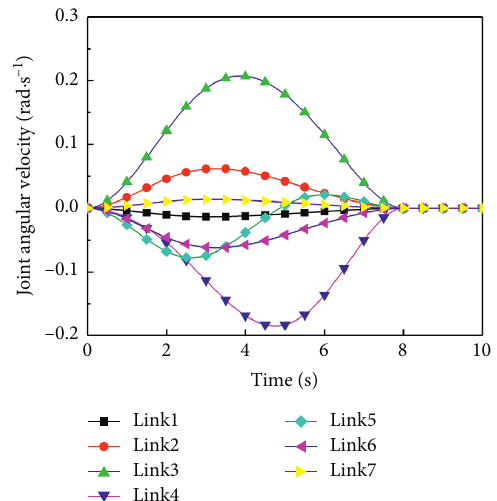
Figure 6: Planning joint angular velocity (rad/s).